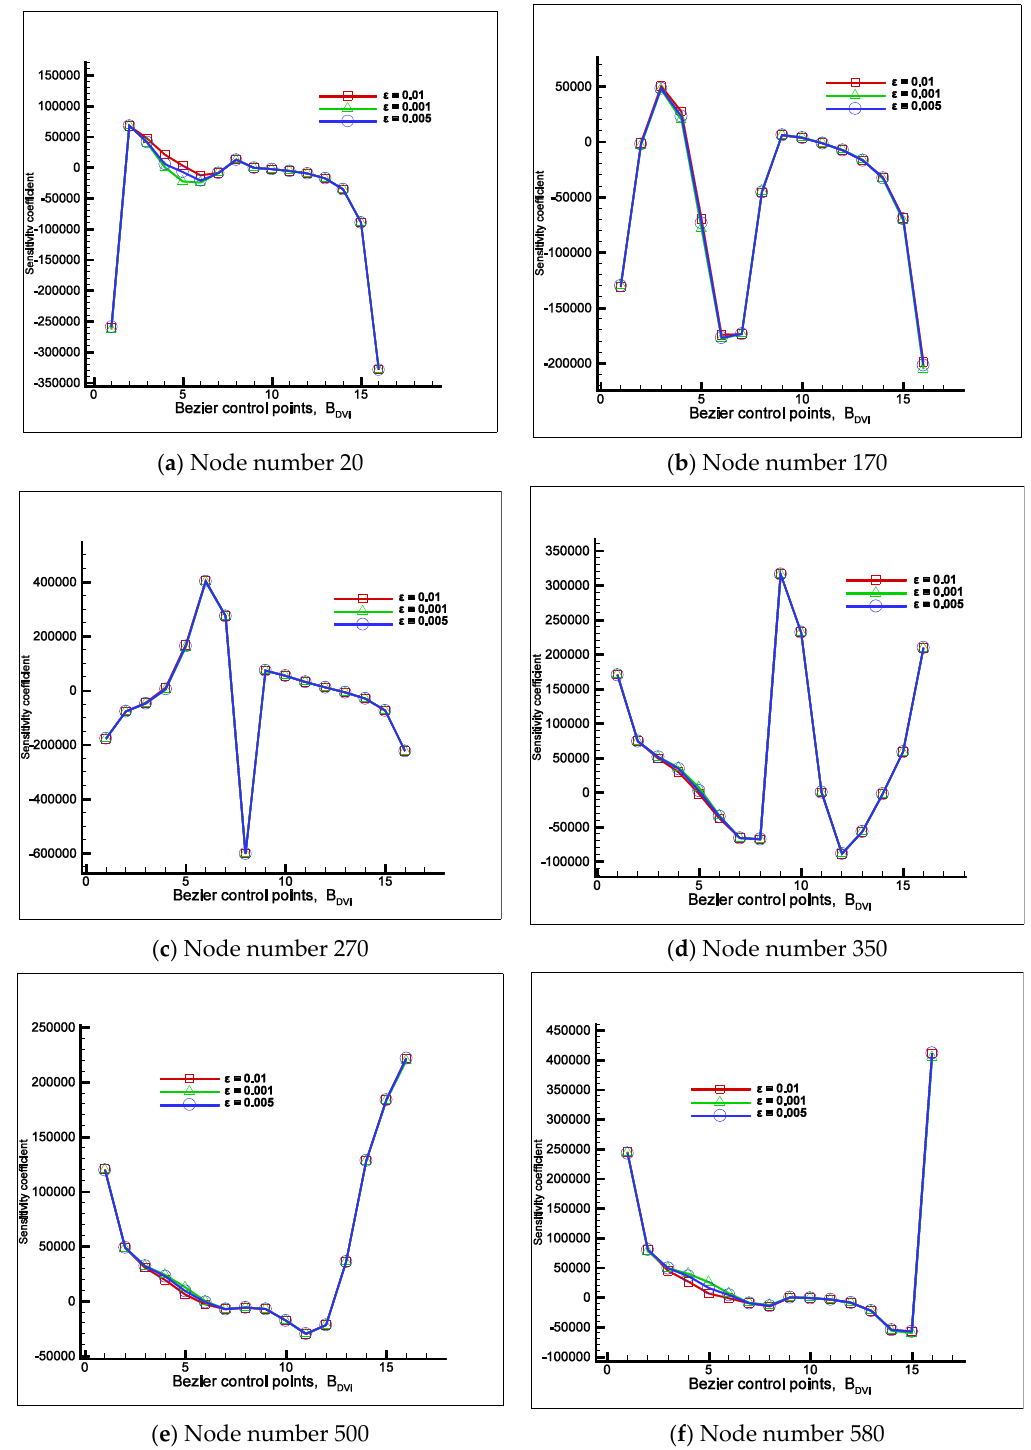
Figure 13. Sensitivity coefficients at some arbitrary nodes using three different finite-difference stepsizes.